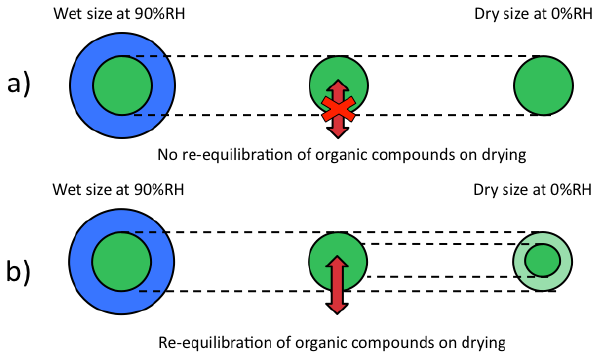
Fig. 1. Cartoon schematic illustrating the two different assumptions used in calculating the multicomponent particle hygroscopicity: (a) only water evaporates on drying, leaving the condensed organic ma- terial at 90%RH representing the dry material. (b) All semi-volatile compounds re-equilibrate on drying, requiring absorptive partition- ing calculations at 0%RH using the same total abundance used in partitioning calculations at 90%RH. At the left side of the figure, each circle represents an aqueous aerosol (blue area equivalent to water and green equivalent to condensed organic material plus a core. The middle portion of the figure illustrates whether organic semi-volatiles are allowed to evaporate (single red arrow) or are not allowed to evaporate (crossed red arrow) on drying. The right portion of the figure illustrates the resulting aerosol at 0%RH, the light green representing the equivalent volume fraction that parti- tions into the gas phase on